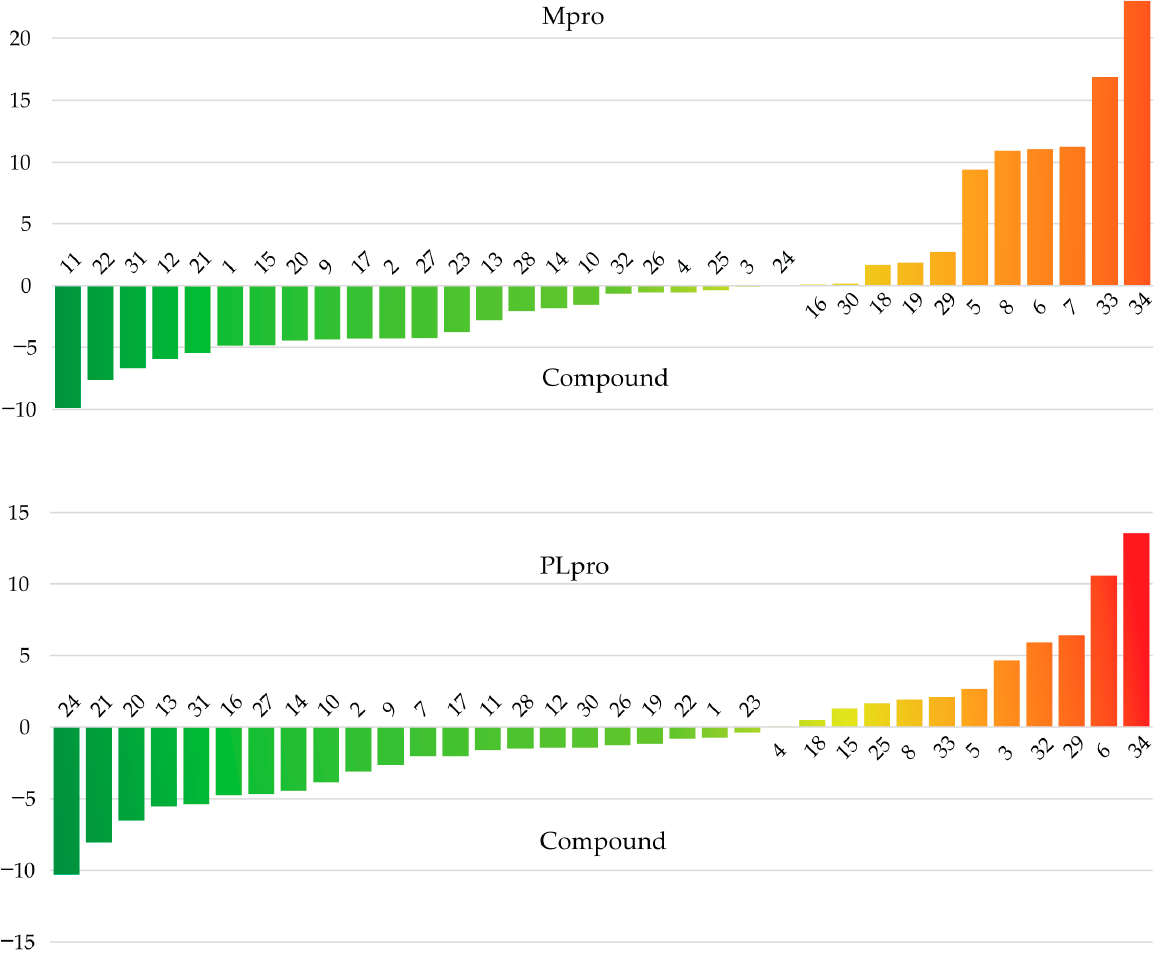
Figure 3. Predicted free energies of binding of the investigated compounds to the M pro (top) and PL pro (bottom) enzymes of SARS-CoV-2. Compounds are ranked, for each target, from lowest (best) to highest (worst) Δ G of binding.